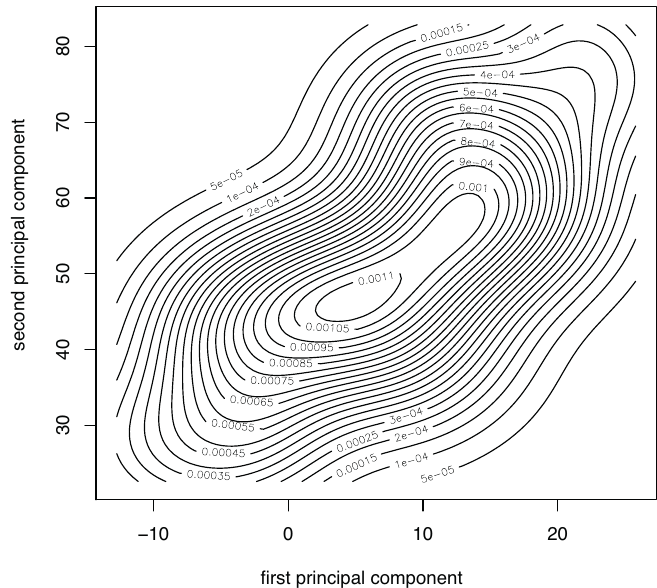
Figure 5. Contour plot for the sample corresponding to fault number 4, and principal components 1 and 2. The contour lines are similar to ellipses of a MVND. The distribution, in this case, is consistent with the assumption of